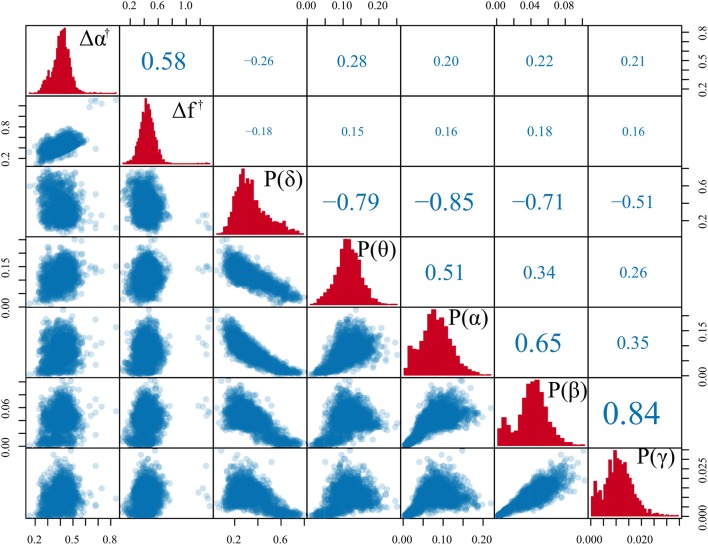
Comparison of multifractal measures with classical spectral band power. Scatter plot matrix comparing both standardized multifractal spectrum width and height (Δα† and Δf†) with the δ, θ, α, β, and γ average band power in each epoch. Each scatter point is derived from a single epoch of the time series. The diagonal of the matrix features the histograms for each measure. The lower triangle contains the scatter plots for each pair of measures. The upper triangle shows the Pearson correlation for each pair of measure, where the size of the font additionally corresponds to the correlation coefficient to provide an additional visual cue. The icEEG data underlying this figure is shown in Figure 4A.